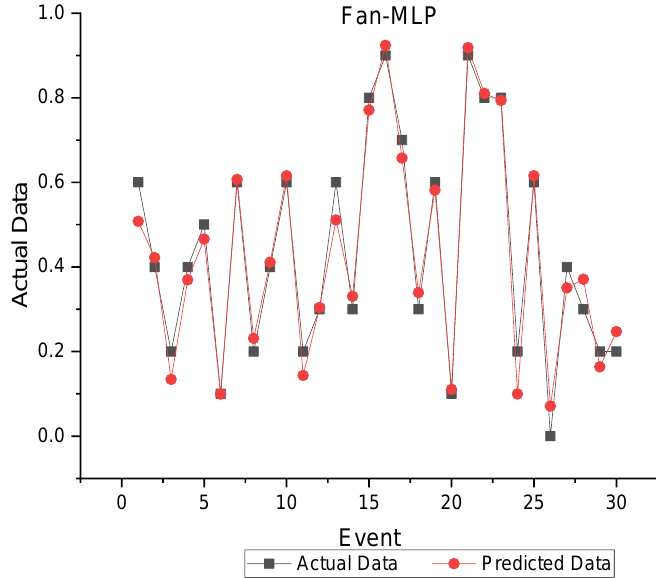
Figure 17. Representation of actual and prediction data for fan MLP.